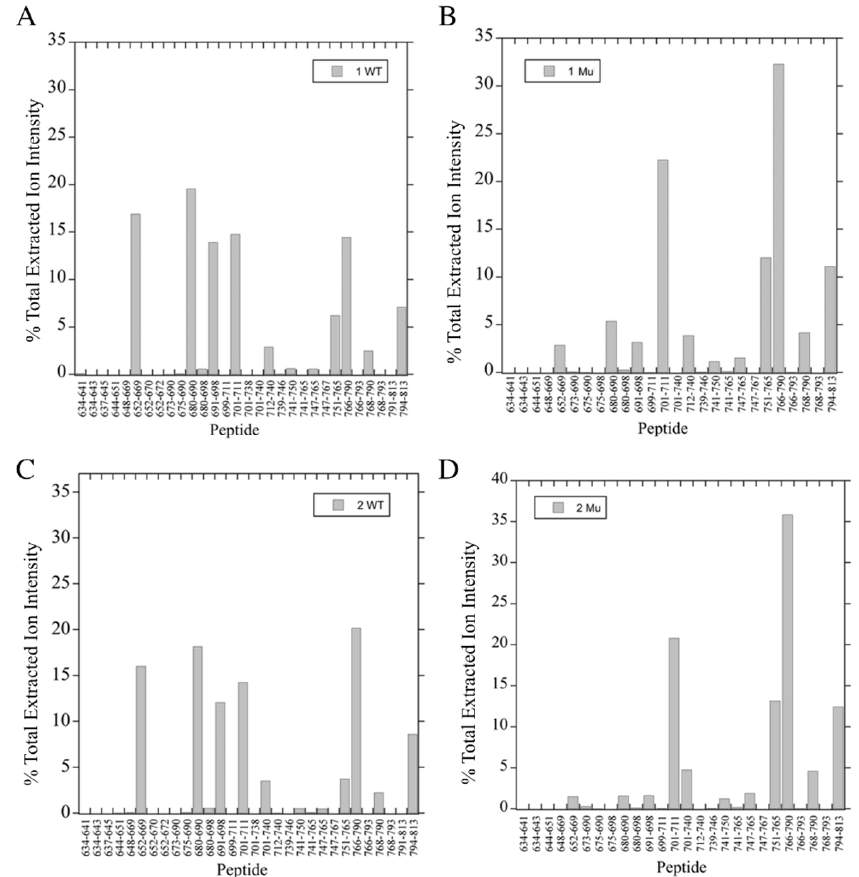
Figure 5. ( A – D ) Mass spectrometry analysis of tryptic fragments of bands 1 ( A , B ) and 2 ( C , D ) of wild- type ( A , C ) and phosphomimetic mutant ( B , D ) His-182 proteins. The bands were excised and treated with trypsin and fragments were analyzed by mass spectrometry as described in Section 4. The sum of the total extracted ion intensity was used to plot the observed relative amount of each fragment. WT, wild-type His-182 protein, Mu, phosphomimetic mutant His-182 protein. The theoretical peptides are shown on the X-axis. % of total fragments found is plotted for each